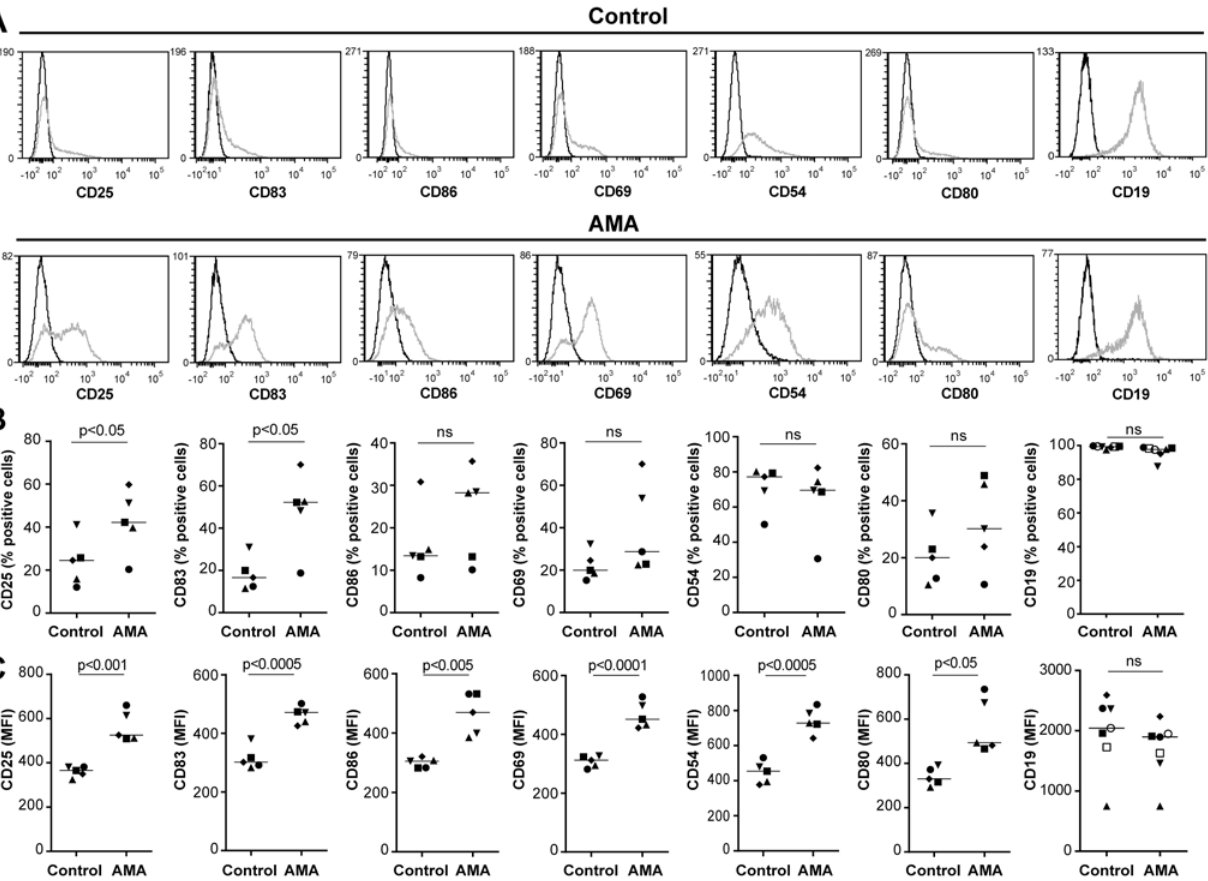
Fig 1. L . infantum amastigotes activate human B cells. Purified human B cells were either left alone (used as a control) or incubated overnight with L . infantum amastigotes (AMA) at a final parasite:host cell ratio of 3:1. Cells and the cell-parasite mixture were intensively washed with a galactose-modified PBS/EDTA solution and stained with the listed antibodies. Samples were read using a BD FACSCanto flow cytometer. A) Representative histograms displaying expression of each cell surface marker studied are shown in this panel. Dark lines on the histograms represent the fluorescence minus one (FMO) control for each sample. B) Results represent mean values of samples from 5 to 7 different healthy donors and are expressed as the percentages of positive cells for the indicated cell surface marker. C) Results represent mean values of samples from 5 to 7 different healthy donors and are expressed as the mean fluorescence intensities (MFI) for the indicated cell surface marker. P values were calculated by the two-tailed Student ’ s t-test (ns: not significant).